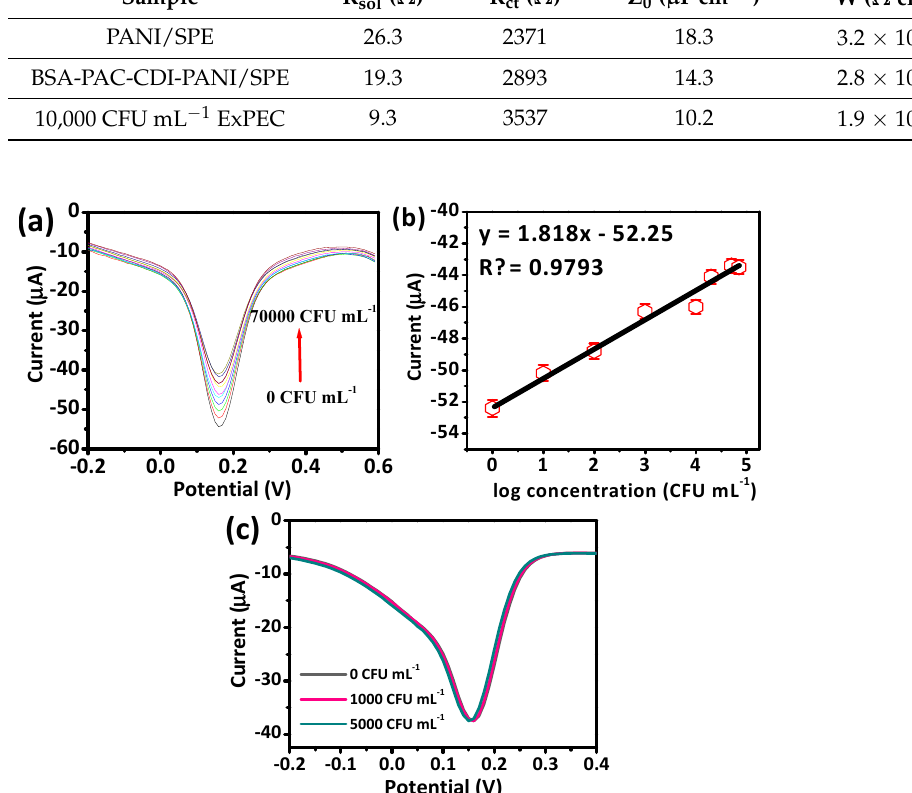
Figure 6. ( a ) DPV curves at varying concentrations of ExPEC from 0 to 70,000 CFU/mL at PAC- PANI/SPE in 0.1 M KCl solution containing 5 mM [Fe(CN) 6 ] 3-/4- . ( b ) Calibration curves of peak current versus the logarithmic value of ExPEC concentration. ( c ) DPV curves at various concentrations of ExPEC at PANI/SPE in 0.1 M KCl solution containing 5 mM [Fe(CN) 6 ] 3-/4- . Table 2. Comparison between the proposed method and bacterial biosensors reported.